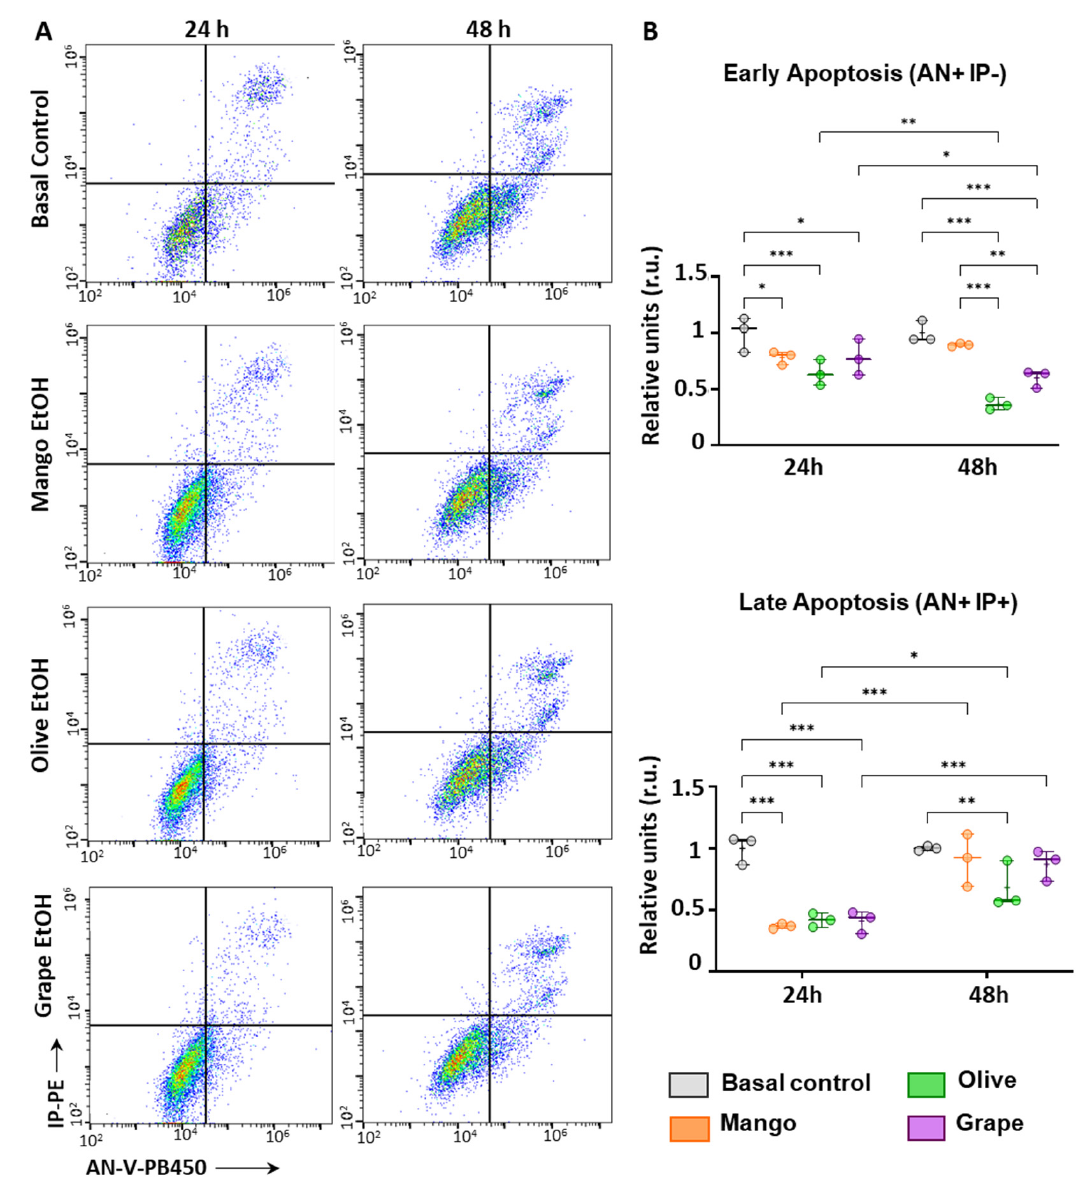
Figure 4. Effect of the selected extracts on the apoptosis of ECFCs. ( A ) Representative dot-plots of